Question: Express in one sentence what the figure is showing.
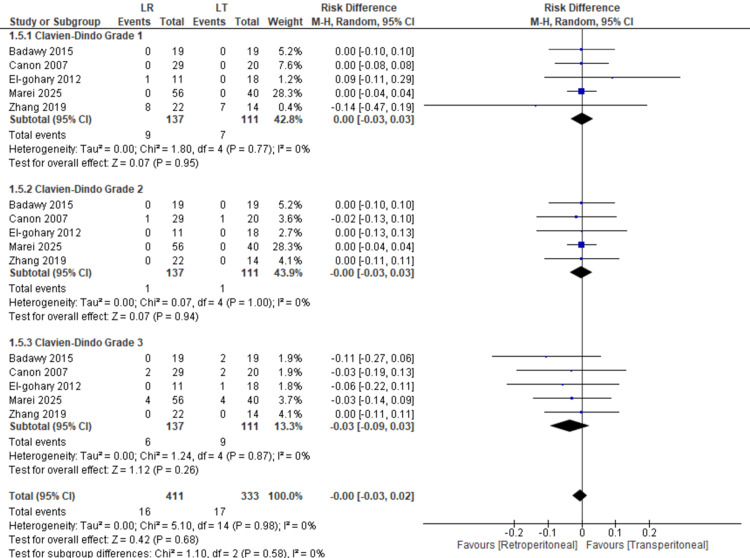
Answer: Meta-analysis of the complication incidence outcomes. This subgroup analysis incorporates data from five studies (N = 248) and excludes the study by Liu et al. [ 26 ] due to the absence of grade-specific reporting. Canon [ 14 ], El-Gohary [ 27 ], Marei [ 24 ], Zhang [ 25 ], Badawy [ 13 ]